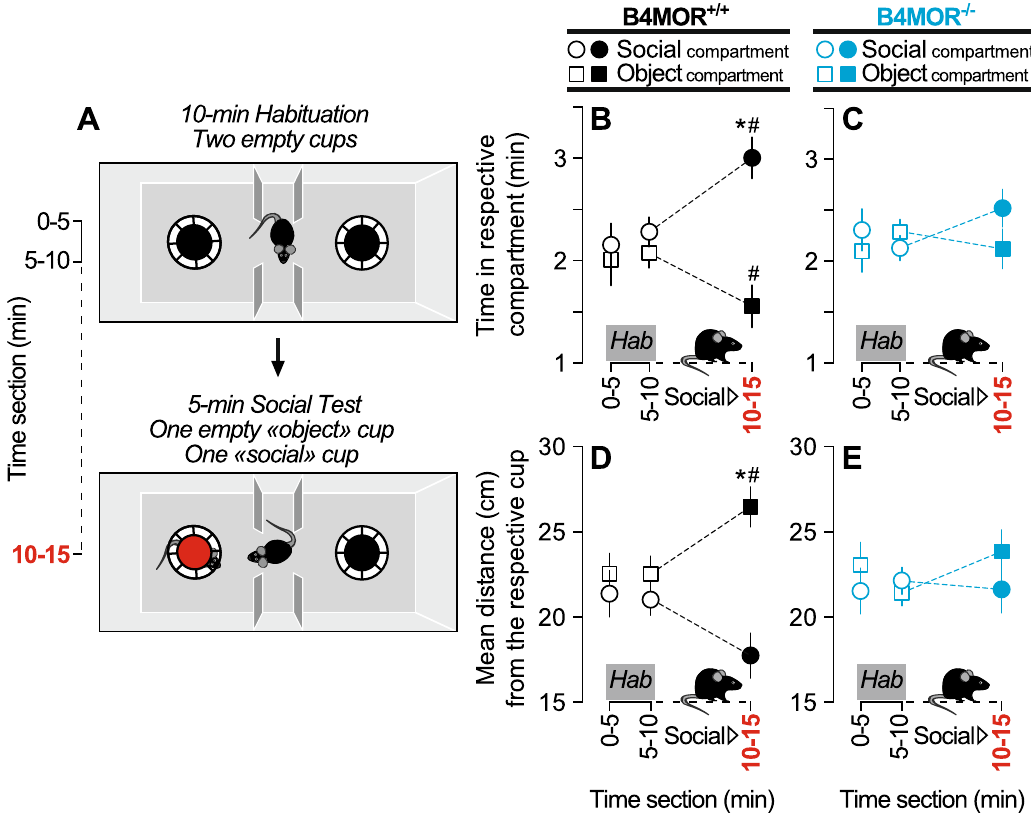
Figure 2. B4MOR −/− mice do not express social preference in the three-chamber social preference test. ( A ) Schematic representation of the social preference test. ( B,C ) Time spent in the social versus object compartment in B4MOR +/+ and B4MOR −/− mice, respectively. ( D,E ) Distance from the social versus object cup in B4MOR +/+ and B4MOR −/− mice, respectively. During the social test, B4MOR +/+ mice spent more time in the social compartment ( B ) and were closer to the social cup ( D ). B4MOR −/− mice spent a similar amount of time in